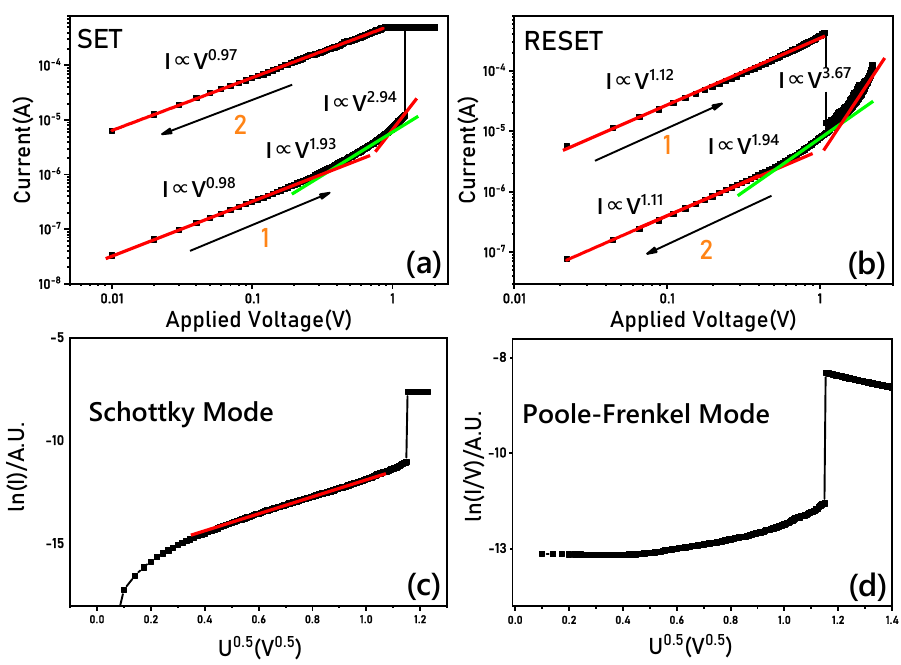
Figure 8. ( a ) Double logarithmic plotting of set process; ( b ) Double logarithmic plotting reset process ( c ) Ln(I)–V 0.5 plotting of the set process; ( d ) Ln(I/V)–V 0.5 plotting of the set process.